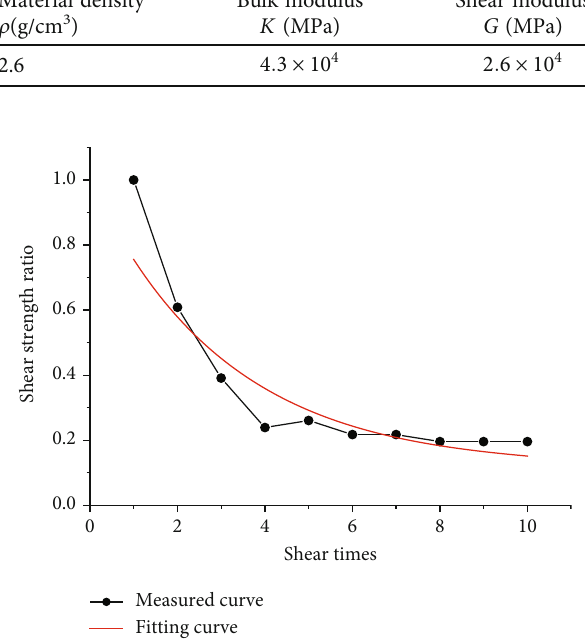
Table 4: Physical and mechanical parameters of the rock mass. Material density ρ (g/cm 3